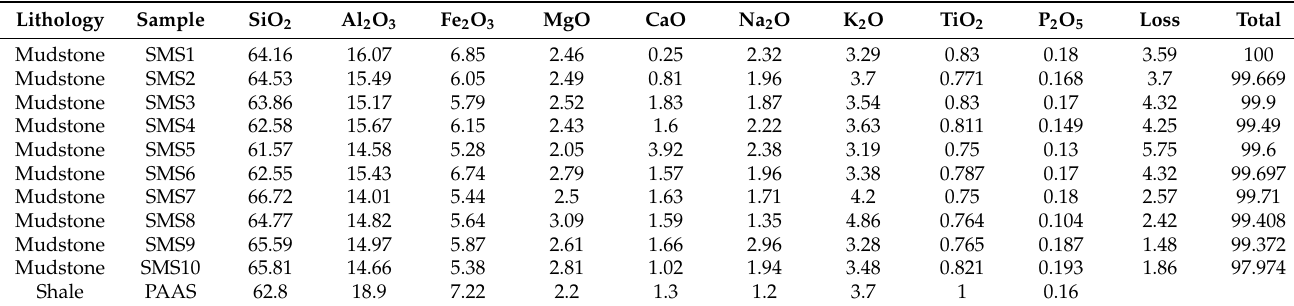
Table 2. Major element composition of black mudstones from the Singa